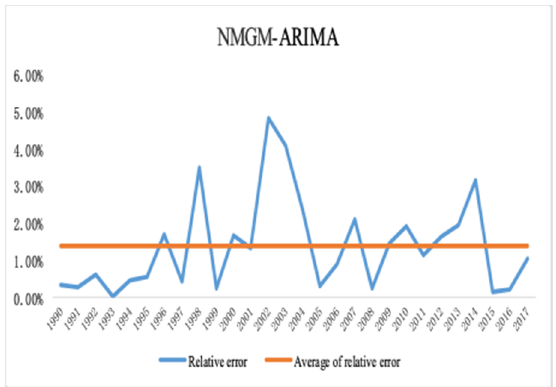
Figure 19. Comparison of relative error of NMGM-ARIMA model coefficient map developed using Eviews 7.2.